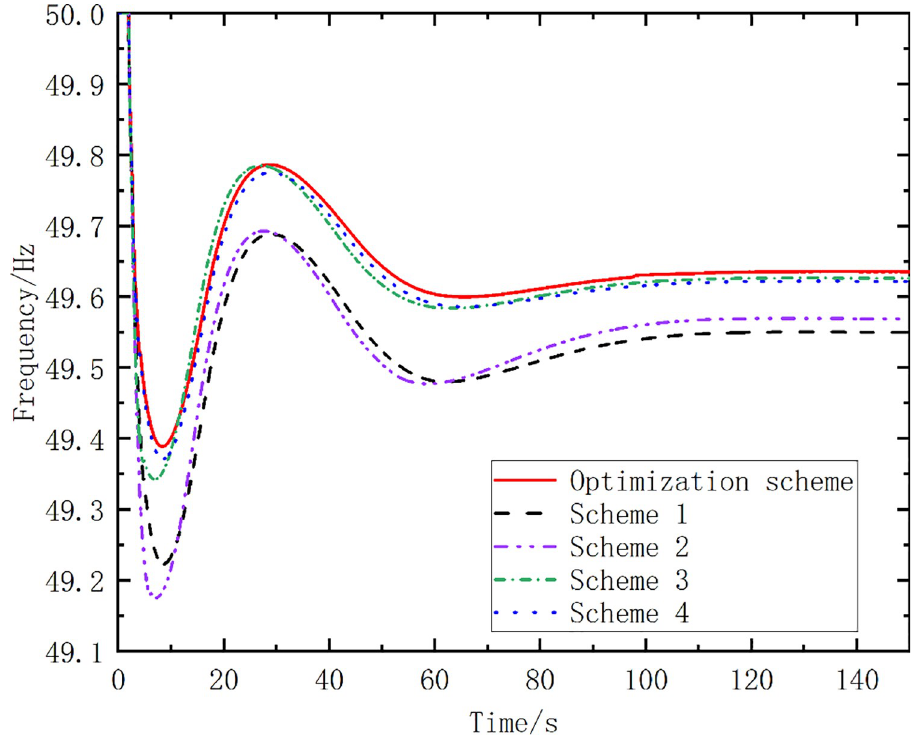
Fig 17. Simulated frequency curves, for the optimized scheme and the other four